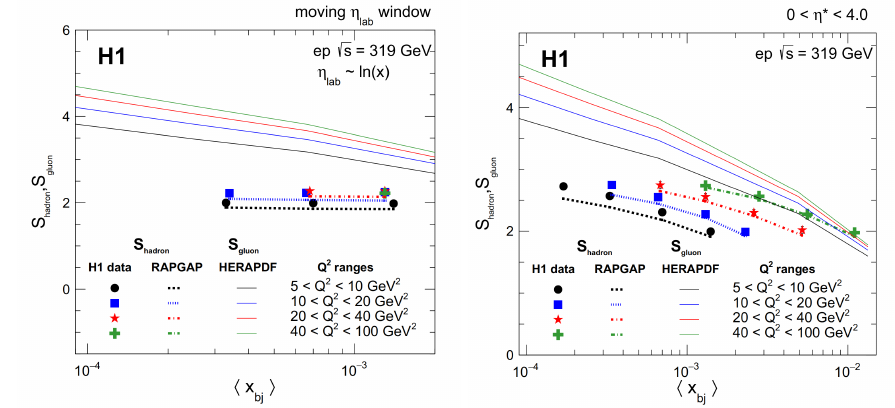
Figure 1: S calculated by charged-particle multiplicity distributions in ep DIS (cid:112) hadron s = 319 GeV, compared with S collisions at η ∼ ln ( x ) , multiplicity definition changes as x lab bj space is restricted by 0 < η ∗ <